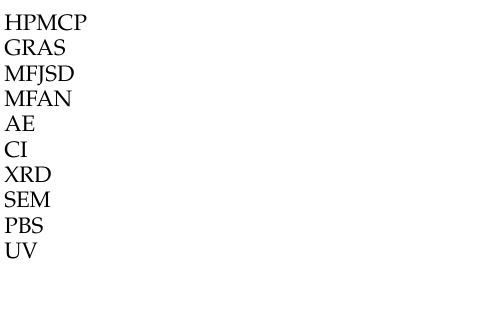
Figure S1: Photographs of the MFAN nozzle (a); and the spray drying set-up (b); Figure S2: SEM images of the hydrocortisone-loaded microparticles obtained by using an acetone/water solvent of 9:1 volume ratio at a drying temperature of 155 ˝ C; Figure S3: SEM images of the lysine-loaded microparticles obtained with an ethanol/water mixed solvent of 4:1 volume ratio at a drying temperature of 100 (a); 155 (b); and 205 ˝ C (c); respectively, and the particle size variation trend (d) with increasing drying temperature; (e) and (f) are the SEM images of the lysine-loaded microparticles with 10% drug loading obtained with an ethanol/water mixed solvent of 4:1 volume ratio at a drying temperature o155 ˝ C; Figure S4: N 2 sorption isotherms of the lysine-loaded microparticles obtained with an ethanol/water solvent of 1: 4 (a); and 1:1 (b) volume ratio at a drying temperature of 155 ˝ C; Figure S5: XRD patterns of the raw lysine drug (a); and the lysine-loaded microparticles obtained with an ethanol/water mixed solvent of 4:1 at a drying temperature of 100 (b); 155 (c); and 205 ˝ C (d), respectively; Figure S6: After the drug release tests in simulated gastric solutions, SEM images of the hydrocortisone-loaded microparticles obtained at a drying temperature of 155 ˝ C with an ethanol/water mixed solvent of 1:4 (a); 1:1 (b); and 4:1 (c) volume ratio, respectively; Figure S7: After the drug release tests in simulated gastric solutions, SEM images of the lysine-loaded microparticles obtained with an ethanol/water mixed solvent of a volume ratio of 4:1 at a drying temperature of 100 (a); 155 (b); and 205 ˝ C (c), respectively; Figure S8: Time-lapse tracking photographs of dissolution behaviors in PBS solutions of the hydrocortisone-loaded microparticles obtained with an ethanol/water mixed solvent of 1:4 (a); 1:1 (b); and 4:1 (c) volume ratio at a drying temperature of 155 ˝ C. Table S1: Summary of the formulations of precursors for the fabrication of a series of pharmaceutical microparticles via microfluidic jet spray drying; Table S2: Data summary of the particle size, bulk density, tap density, and Carr’s Index for the obtained pharmaceutical